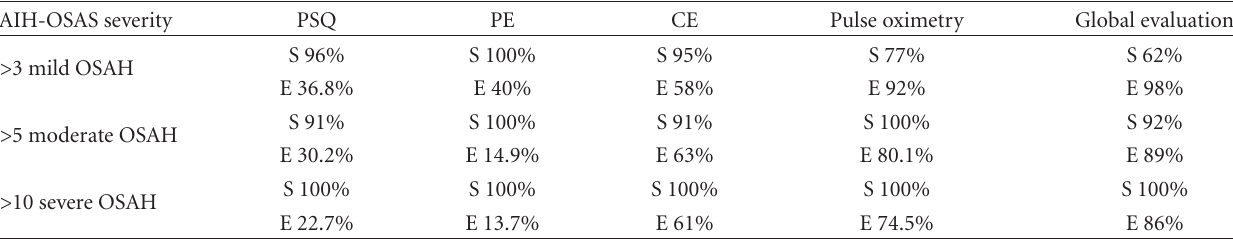
Table 2: Assessment of di ff erent screening tools depending on OSAH severity. AIH-OSAS severity Pulse oximetry Global